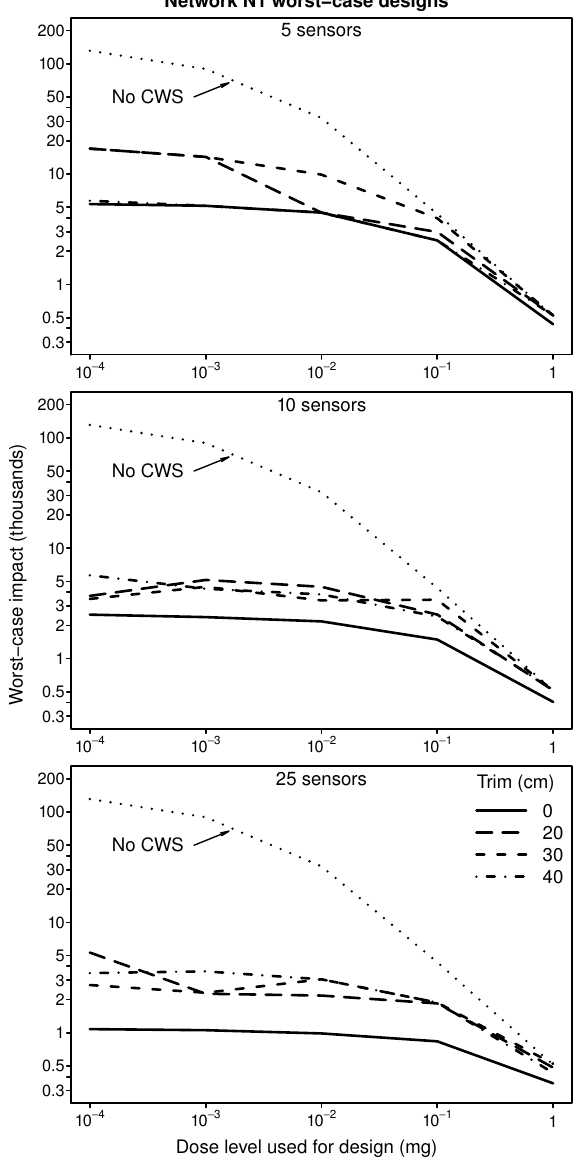
Figure 8. Worst-case impact versus dose level for original and transplanted, worst-case CWS designs for Network N1, nonzero de- mand nodes only. Results are shown for the original model and three levels of network skeletonization